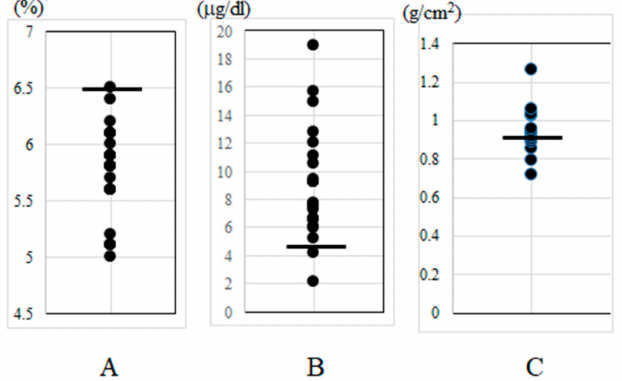
Figure 1. Scatterplots of ( A ) HgA1c, ( B ) serum cortisol, and ( C ) bone mineral density. Horizontal bars denote the normal limit.